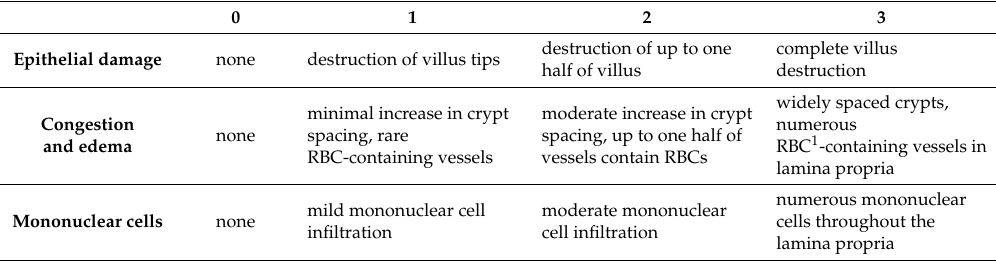
Table 1. Criteria for quantitative estimation of the small intestinal